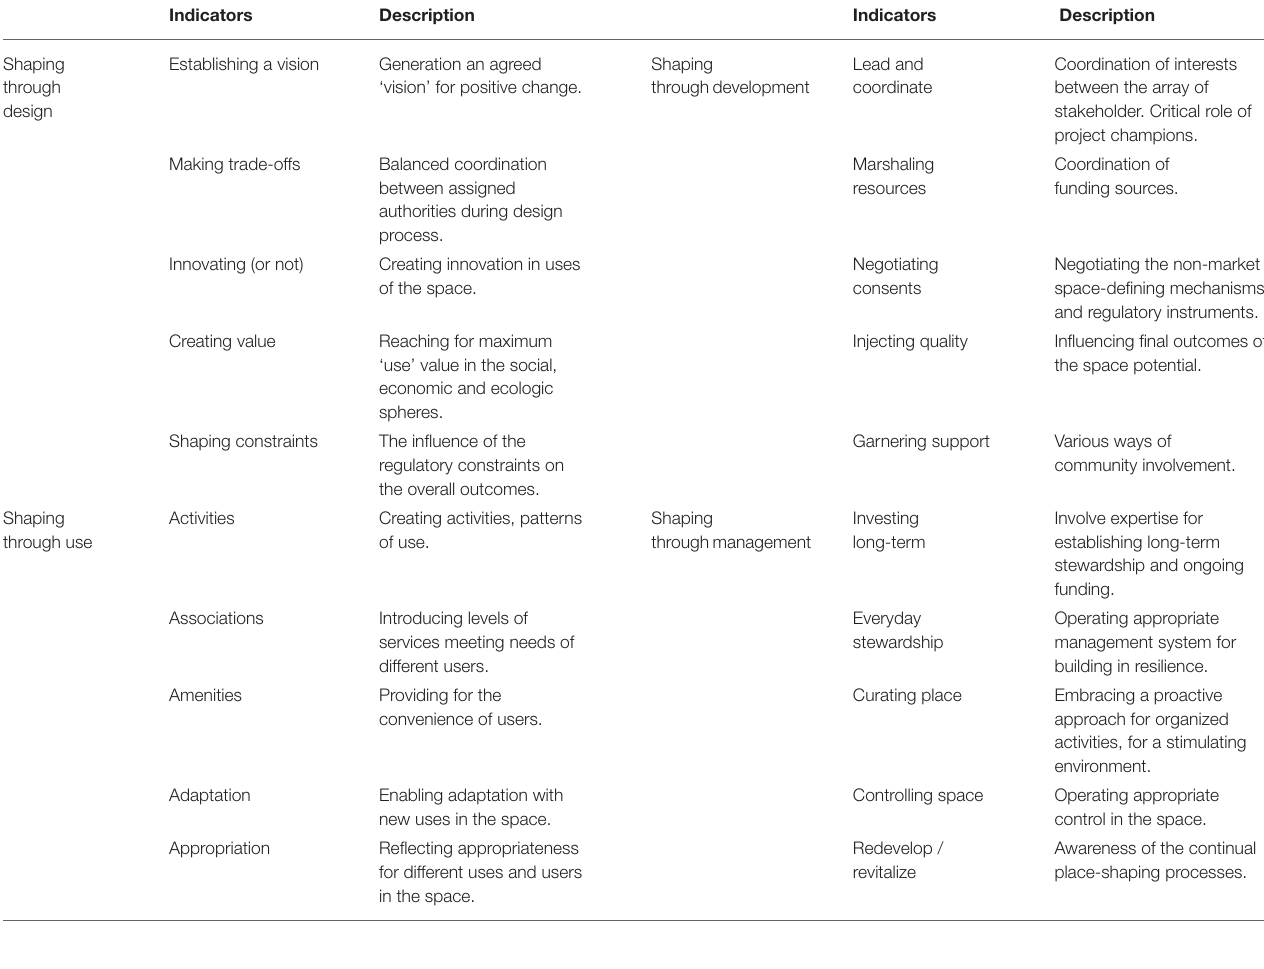
TABLE 2 | Indicators and description of UDP sub-processes (Carmona, 2014).